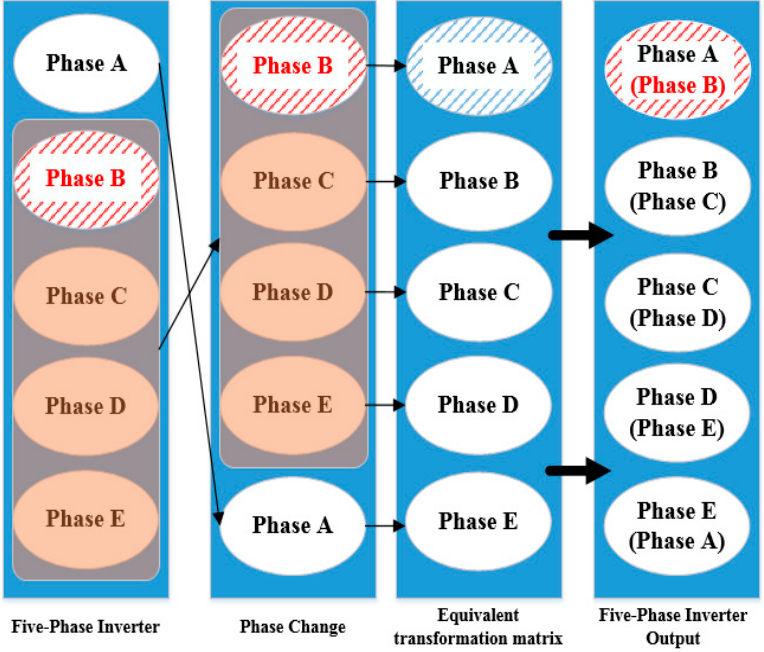
Figure 5. Proposed algorithm for arbitrary open phase fault.